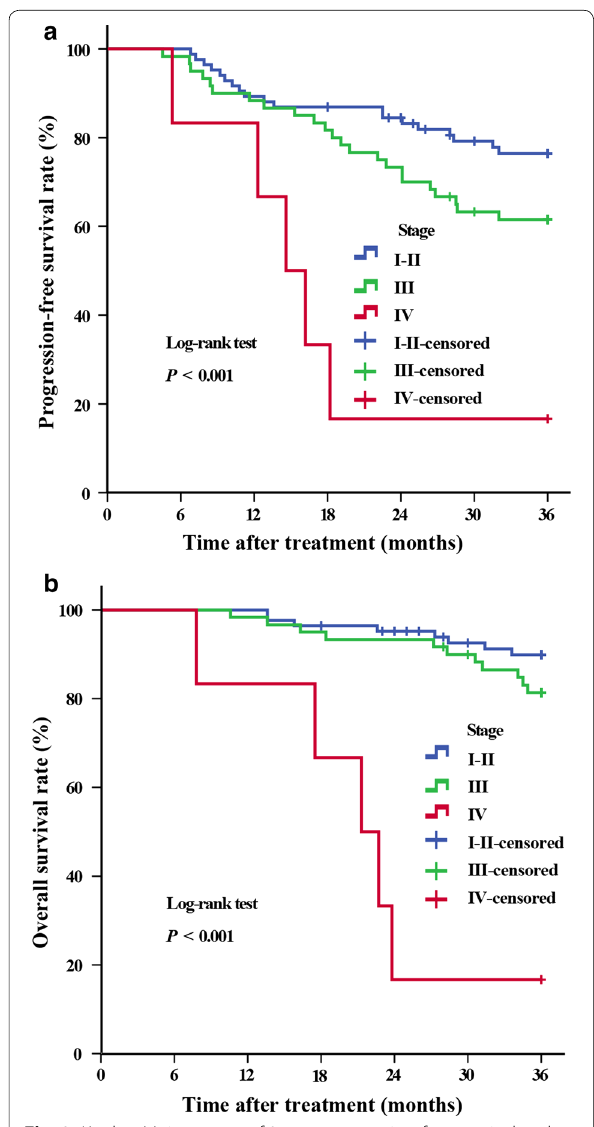
Fig. 2 Kaplan‑Meier curves of 3‑year progression‑free survival and 3‑year overall survival for 150 patients with cervical cancer who were treated with 252 Cf NBT combined with external‑beam radiotherapy (EBRT) plus concurrent chemotherapy. a Progression‑free survival; b overall